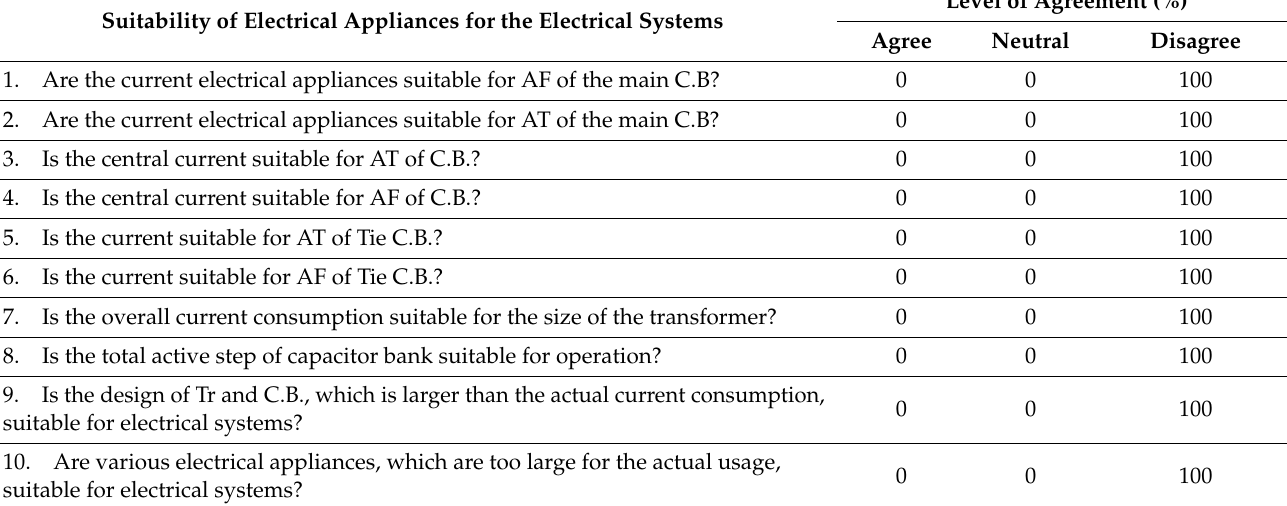
Table 2. Percentage of experts’ assessments of suitability of electrical appliances for the condominium electrical systems. Suitability of Electrical Appliances for the Electrical Systems